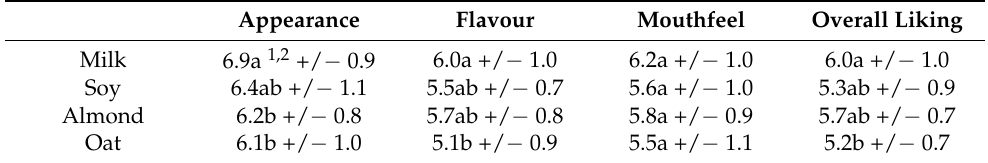
Table 3. Consumer ( n = 116) mean liking scores (+/ − standard deviation) for the different coffee samples.